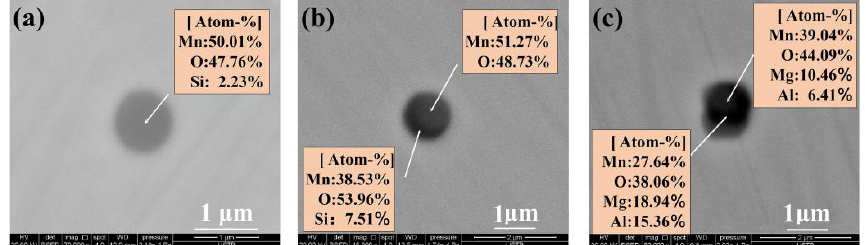
Figure 4. Morphology of typical inclusions after slag–steel reaction: ( a ) MnO; ( b ) MnO-SiO 2 system;